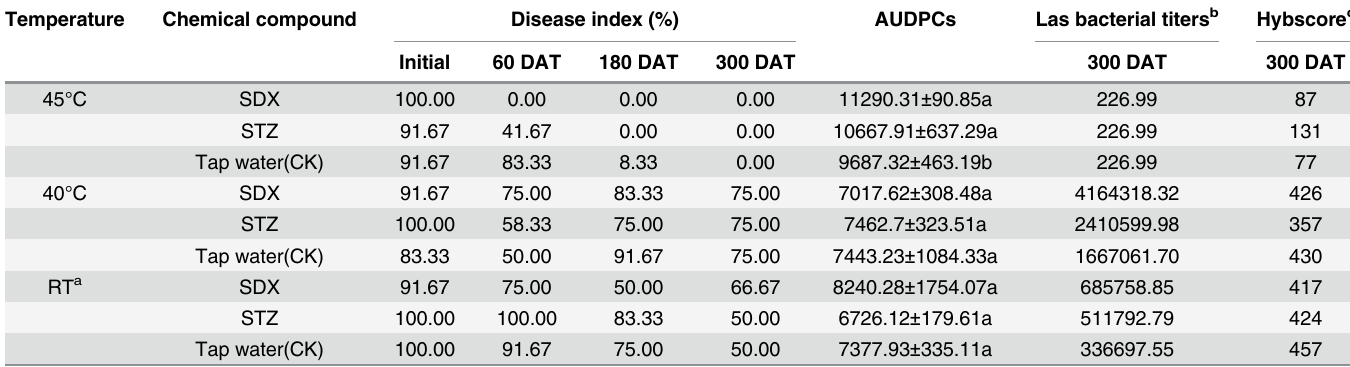
Table 1. Efficacy of thermo-chemotherapy against citrus